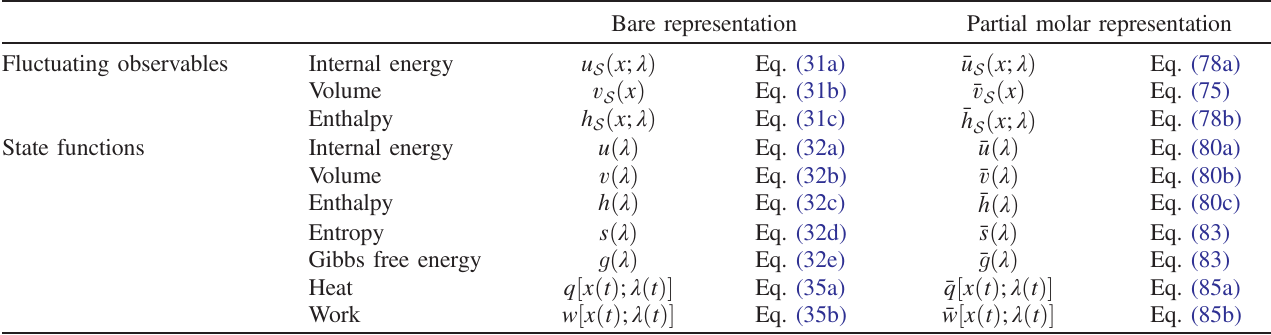
TABLE I. Thermodynamic quantities defined in the bare and partial molar representations are listed, together with references to their defining equations. Although w ¼ ¯ w and g ¼ ¯ g , other quantities generally differ in the two representations ( u S ≠ ¯ u S , q ≠ ¯ q , etc.) All of the listed quantities depend implicitly on P and T